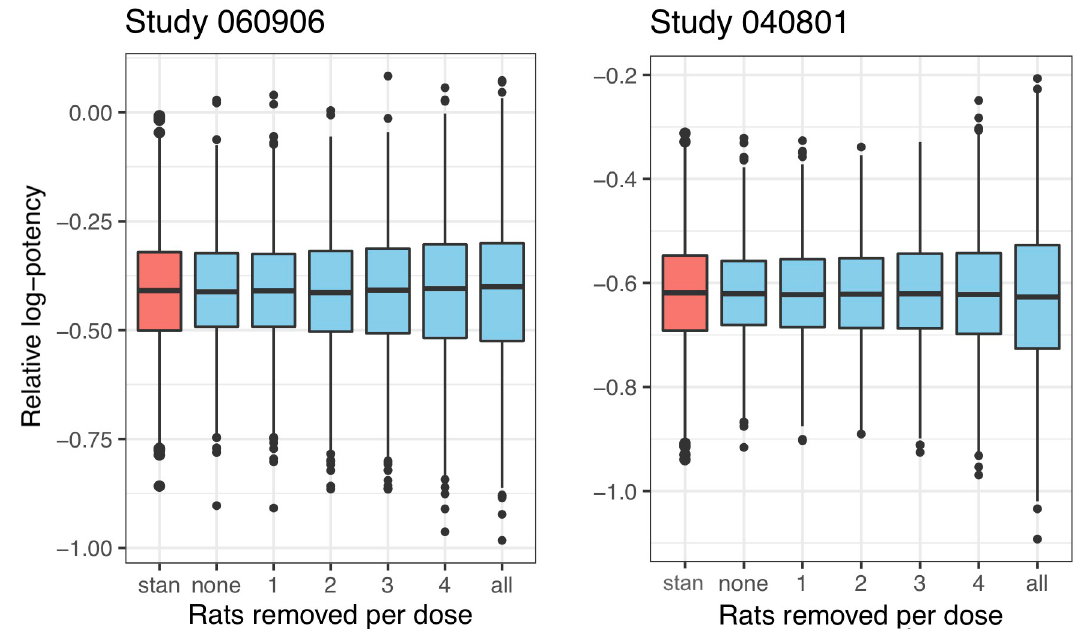
Fig 4. Box plots of the estimated relative log-potency based on 1000 simulations for the two studies. The red box indicates a re-fit using the standard approach, and the remaining blue box plots are the re-fits using the mixed-effects meta-analysis approach, removing different numbers of control rats per dose value: none and all indicate keeping and removing all the control rats, respectively, rem1 indicates removing one control rat per dose value, rem2 removing two and so on.